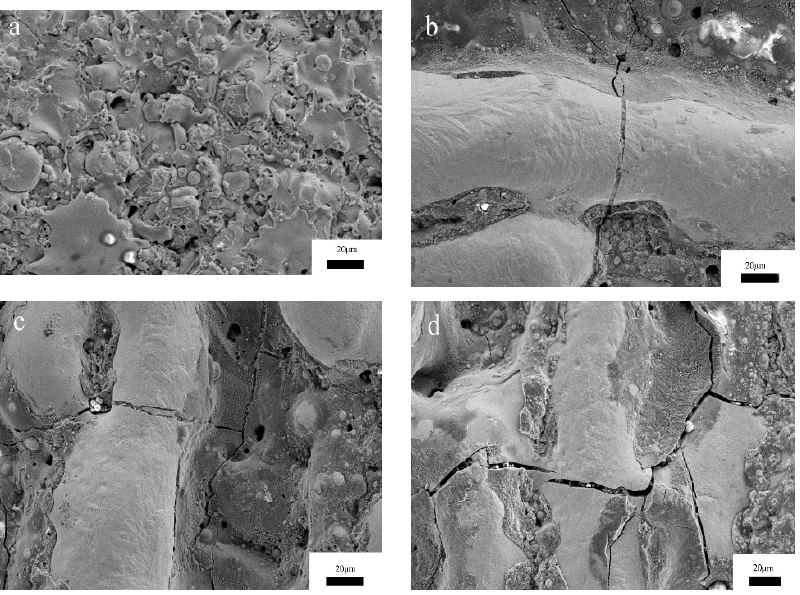
Figure 5. The surface micro-morphology of the amorphous coatings after re-melting with different degrees of laser power: ( a ) 1#; ( b ) 2#; ( c ) 3#; ( d ) 4#.